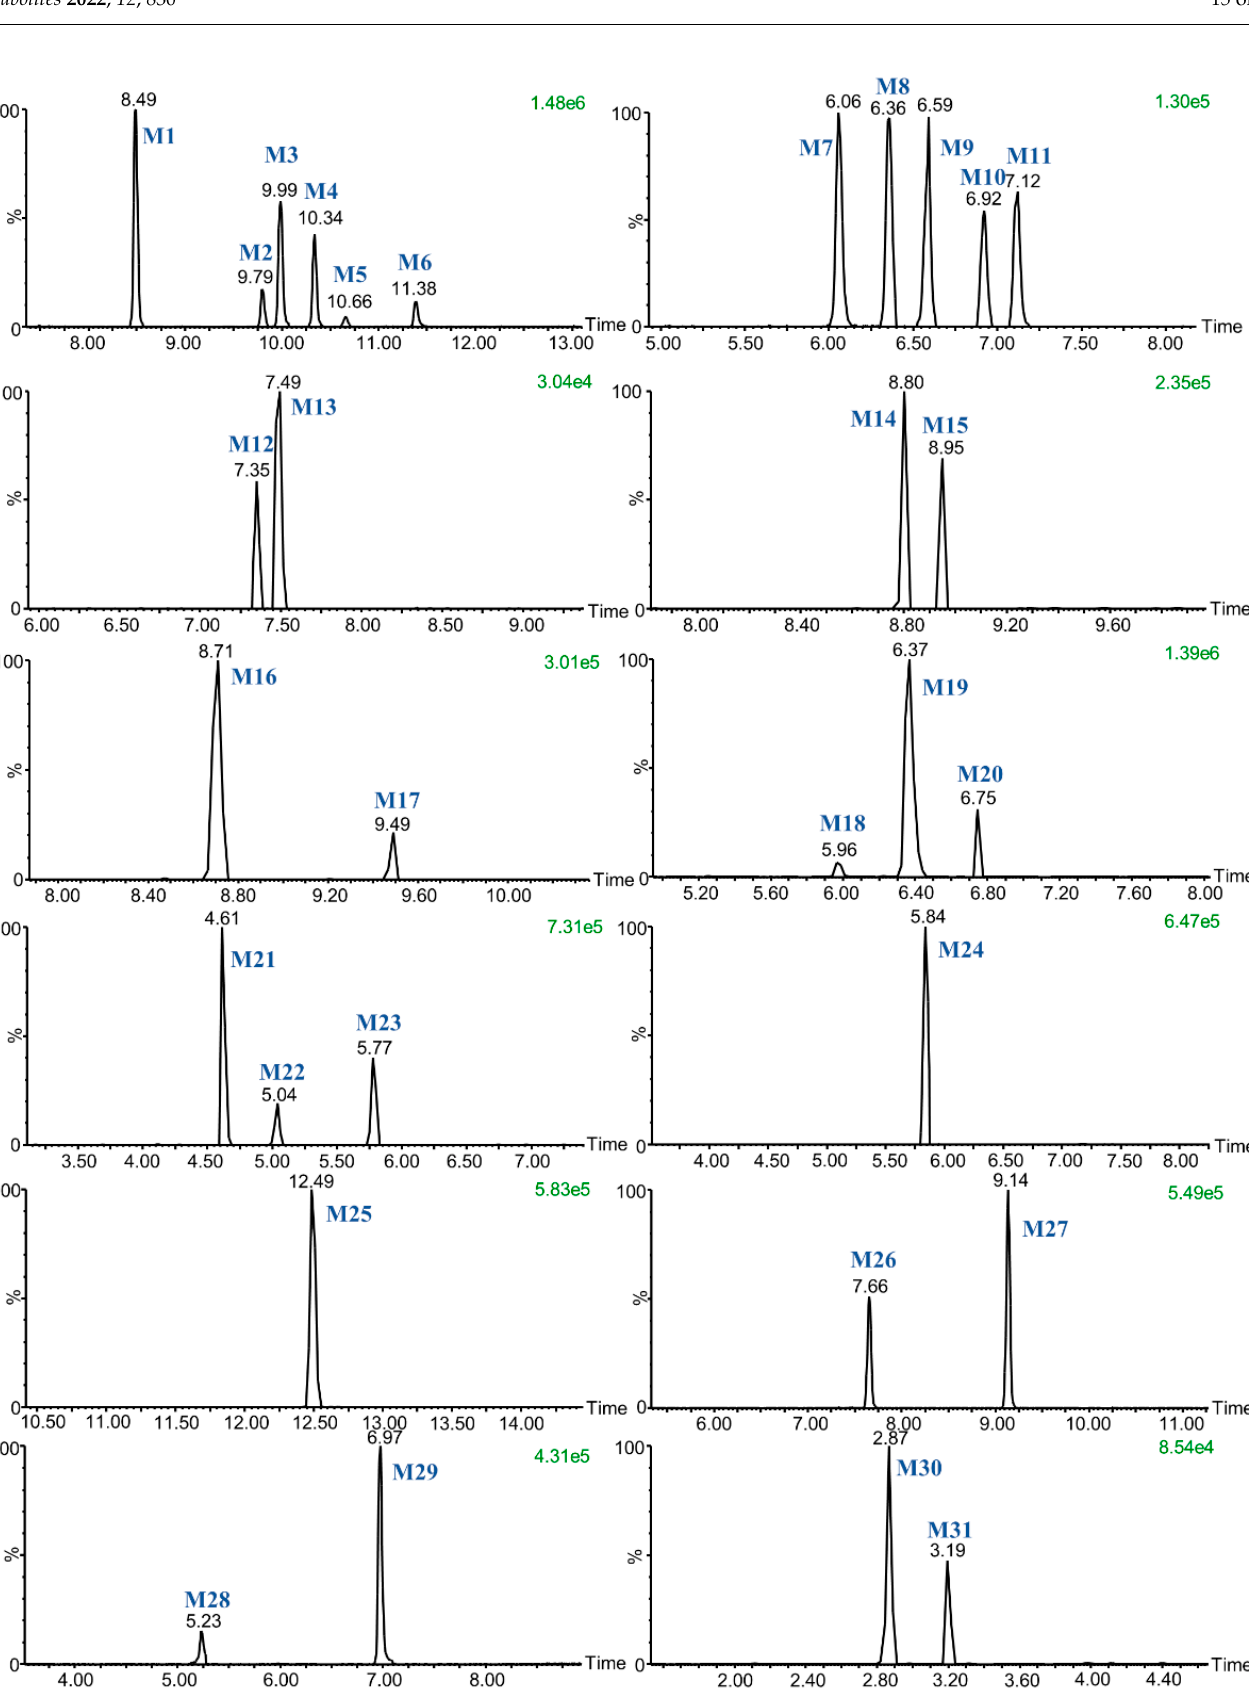
Figure 3. Extracted ion chromatograms of euphorbiasteroid metabolites in rats.